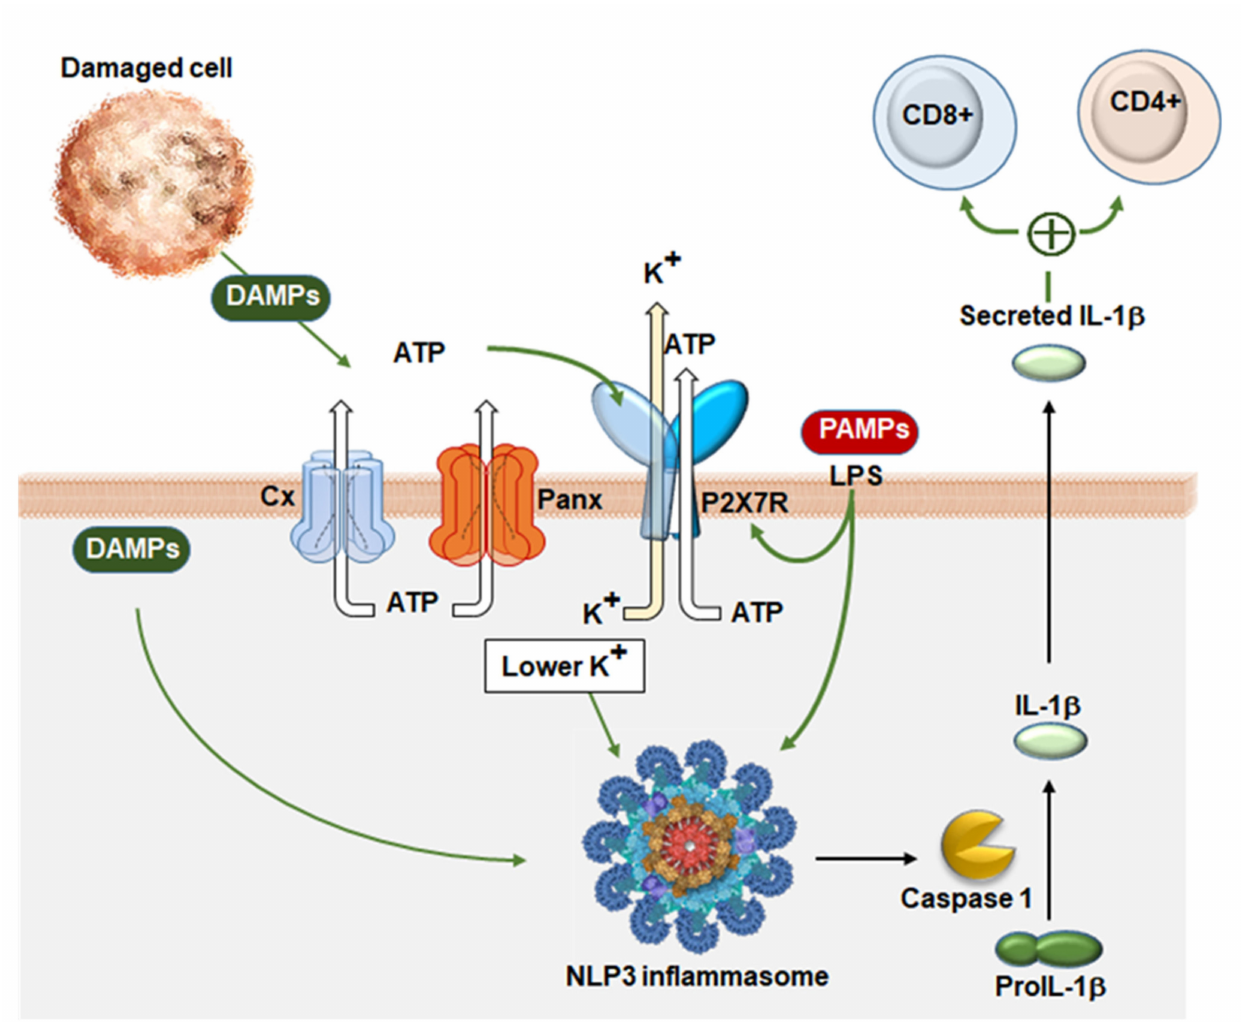
Figure 3. The Panx1/PR signalosome in anti-cancer innate immunity. When a pathogen-associated molecular pattern (PAMP), such as lipopolysaccharide (LPS), binds to innate immunity receptors of phagocytic and dendritic cells (e.g., toll-like receptors, not shown), the activation of the NF- κ B signaling cascade ensues (not shown), which upregulates the expression of the inflammasome component NLRP3, pro-IL-1 β and TNF- α , and the whole complex associates with P2X7R. DAMPs, either shed from dying cancer cells and acting at the plasma membrane or in the cytosol, including ATP, and PAMPs, may cause Panx1 opening and ATP release, which activates P2X7R, allowing calcium flow into the cells and K+ efflux. Lower intracellular K + provokes inflammasome assembly, bringing NLRP3 and pro-caspase 1 together with the adaptor protein ASC. The inflammasome activates pro-caspase 1, that will cleave the pro-peptide from IL-1 β , which is then secreted from the cell along with TNF- α (not shown). Both cytokines increase CD4+ and CD8+ T cells, mediating antitumor